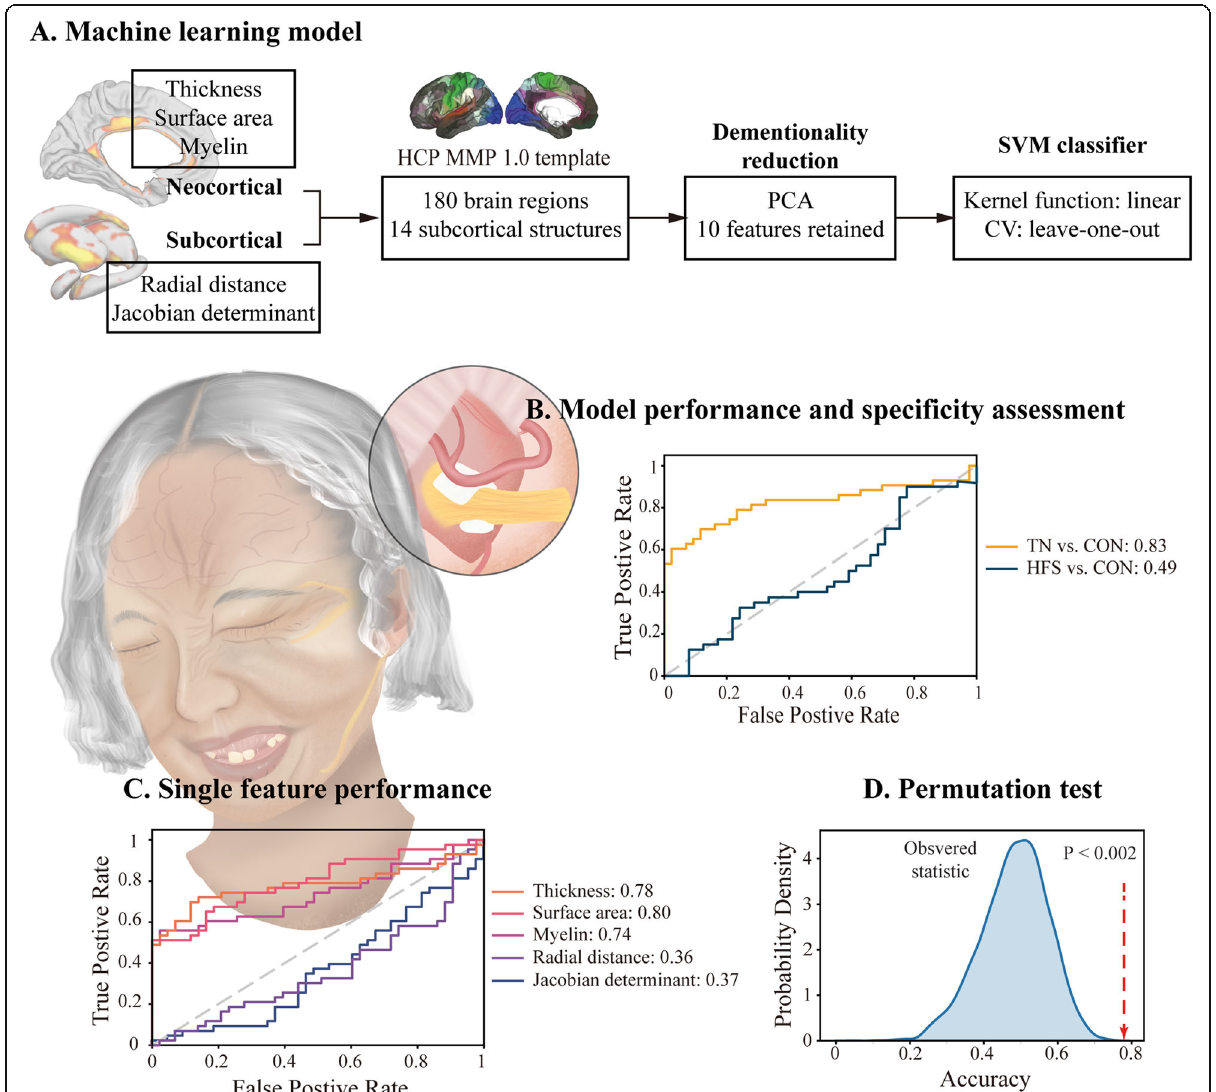
Fig. 3 Machine learning model design and performance. A SVM classifier overview. HCP-MMP1.0: Human Connectome Project Multi-Modal Parcellation version 1.0 [24]; PCA: principal component analysis; CV: cross-validation. B Model performance as a tool for differentiating between TN patients and healthy controls. HFS patients served as disease controls for analyses of model specificity. TN: trigeminal neuralgia; HFS: hemifacial spasm disease controls; CON: healthy controls. C ROC and AUC values for models trained on individual neocortical and subcortical features. D AUC values corresponding to 5,000 permutation tests conducted using the final model. The AUC frequency across 5,000 tests is denoted with a blue histogram, while the real AUC without permutations is indicated by a vertical red